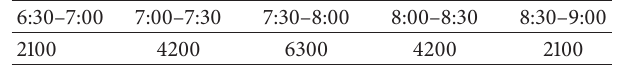
Table 1: Time varying O-D